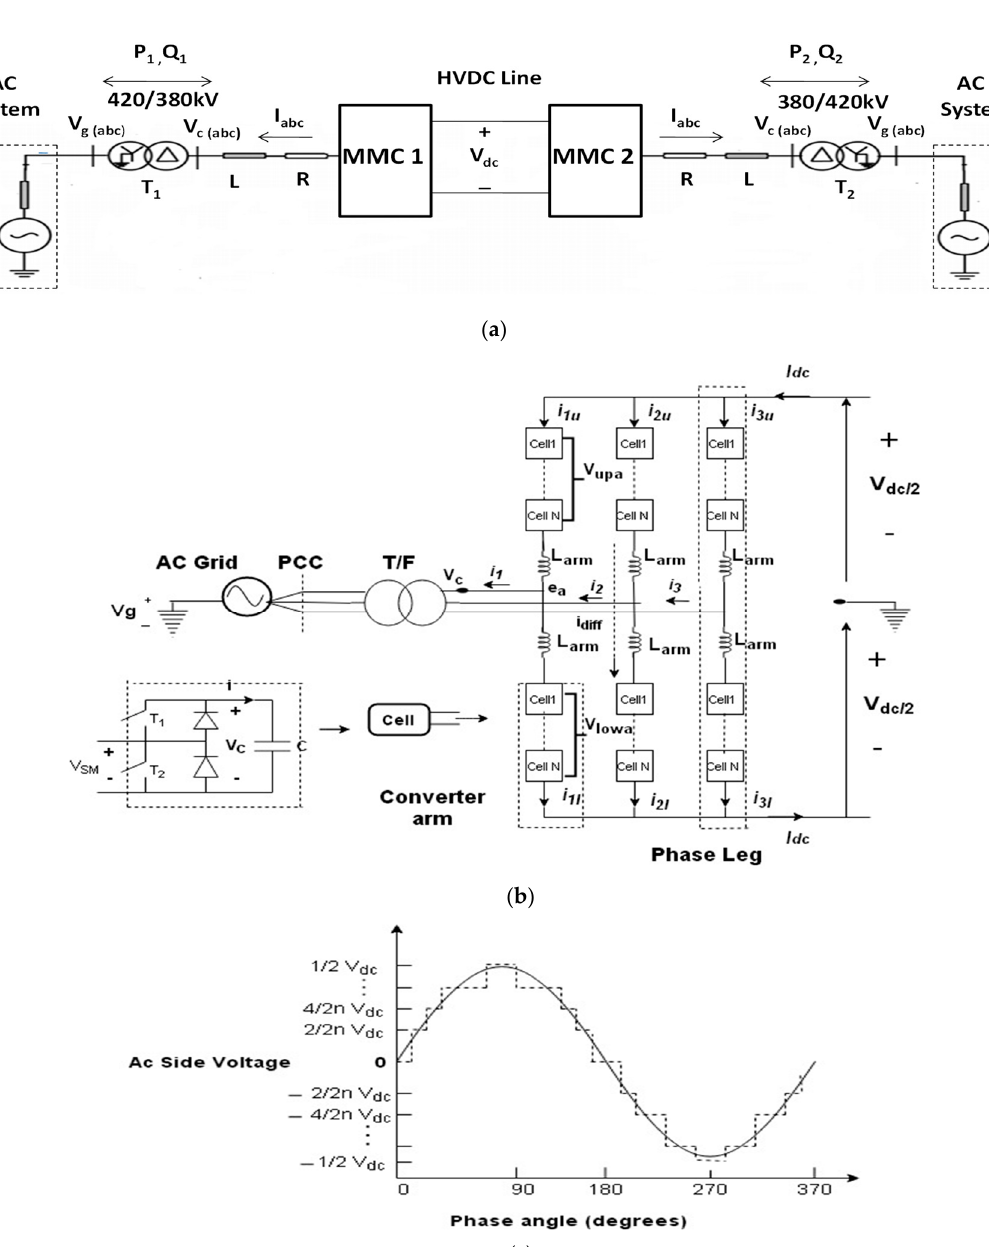
Figure 1. Modular multilevel converter-based high-voltage direct-current (MMC-HVDC) system: ( a ) single line diagram; ( b ) circuit diagram; ( c ) AC side